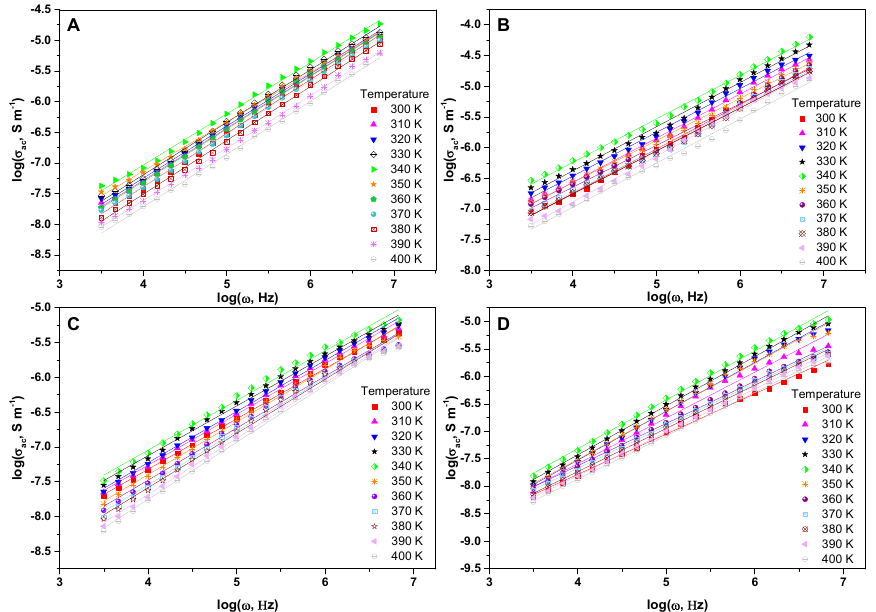
Figure 8. Dependence of log(σ ac ) on the frequency at different temperatures for ( A ) poly(EDMA),